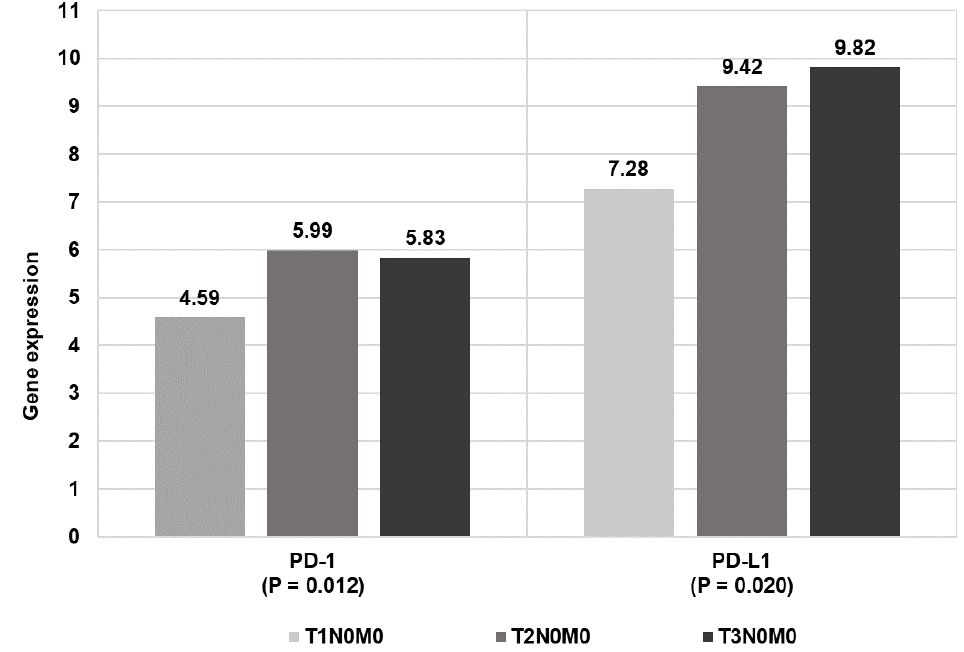
Figure 2. PD-1 and PD-L1 mean expression in patients with laryngeal cancer by TNM classifica- tion.